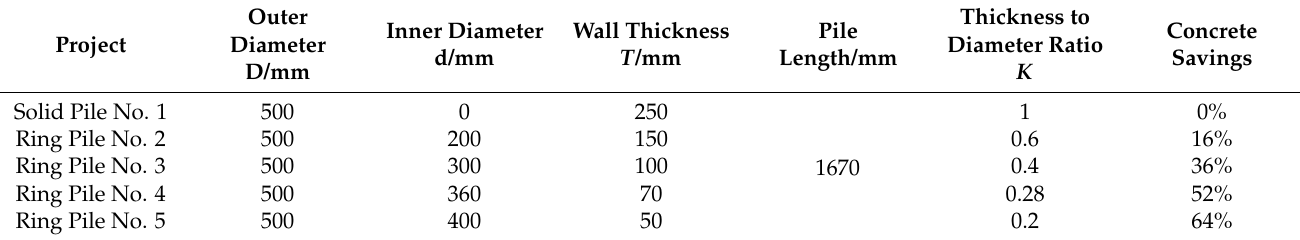
Table 1. Model pile’s specifications.